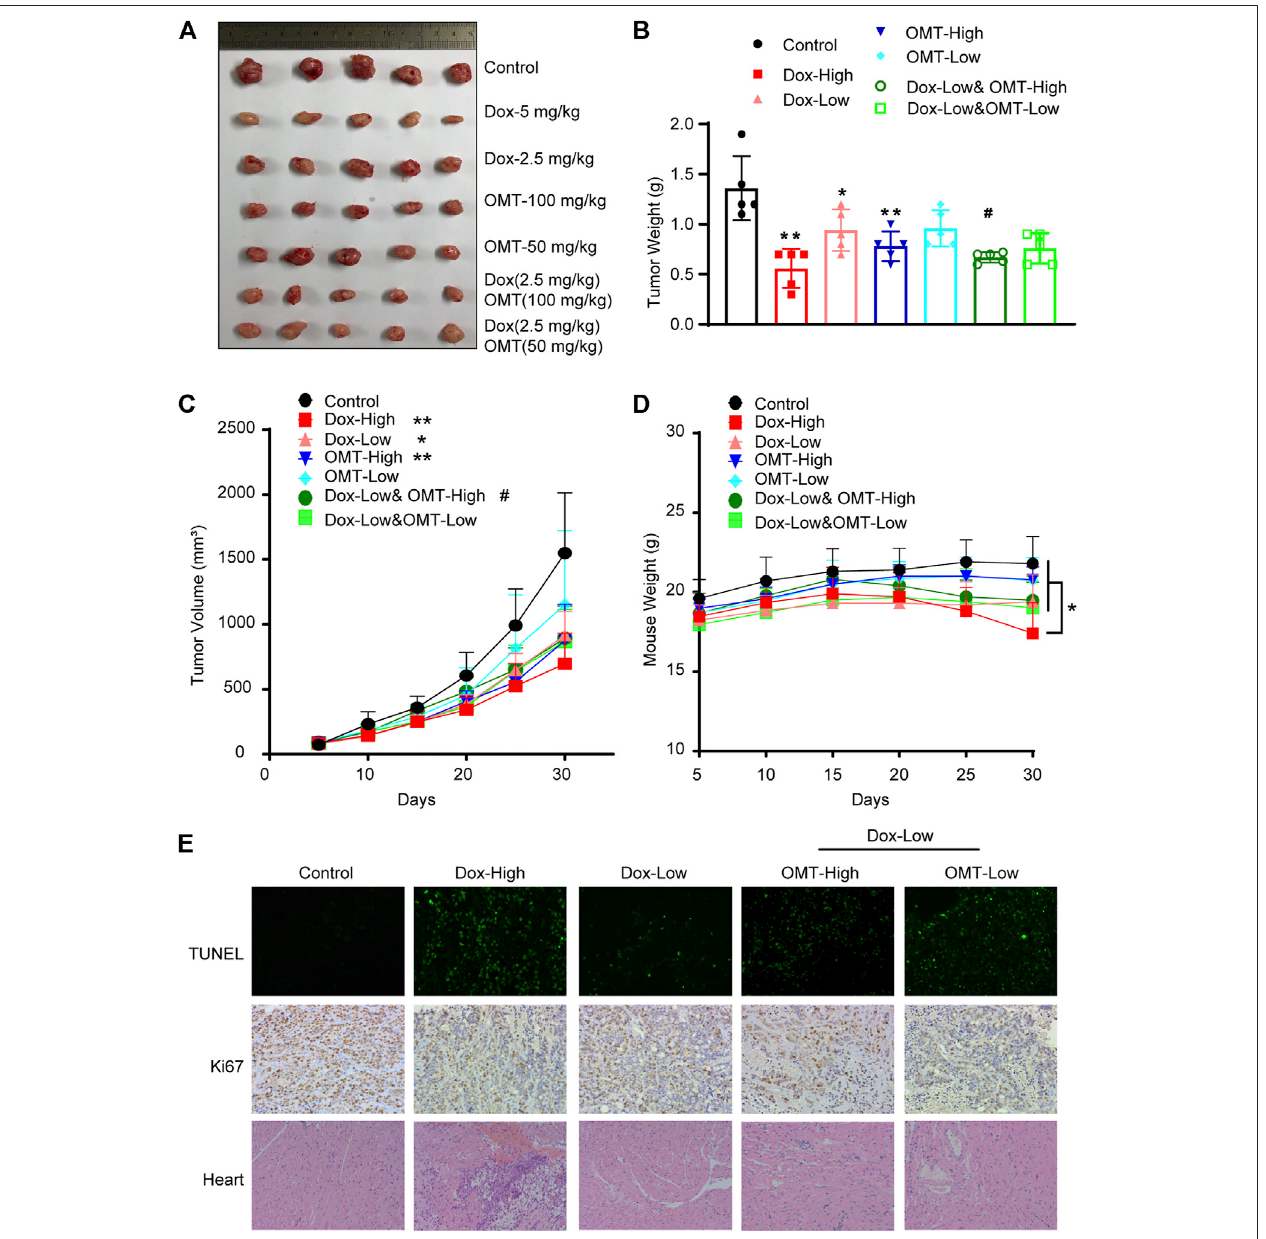
FIGURE 6| Effects ofOMT and DOX on tumor growth in aCRCxenograftmodel. A CRC mouse model wasestablished by introducing a xenograft of HT-29 cells. Themiceweretreatedwithsaline(control),OMT,Dox,orOMTplusDOX. (A) Imageofexcisedtumorsattheconclusionoftheexperiment. (B) Weightofdifferentgroups of tumor tissue. (C) Tumor volume progression as a function of time. (D) Mouse weight as indicated over time. (E) Representative images of hematoxylin and eosin stainingon cardiac tissue sections, TUNEL assayand immunohistochemical staining withantibodies toKi67 on tumor tissuesections. * p < 0.05, ** p < 0.01vs. the control group or DOX (5 mg/kg); # p < 0.05, vs. the DOX (2.5 mg/kg)